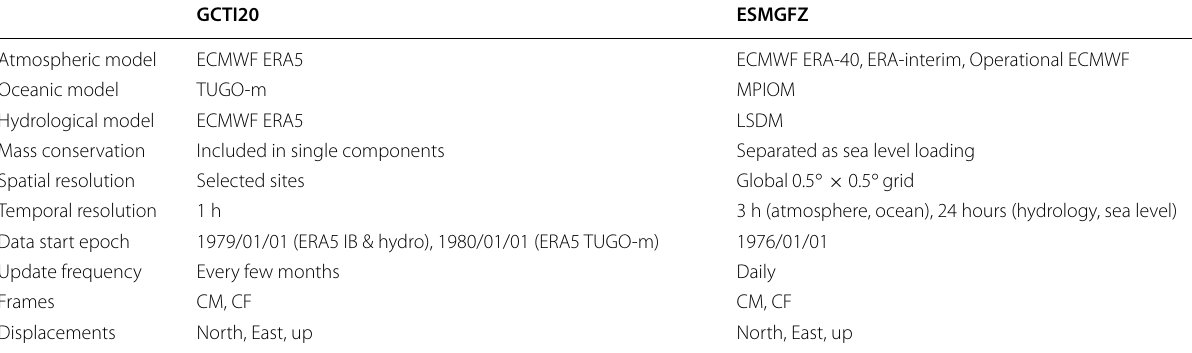
Table 1 Summary of the non-tidal loading data sets compared in this study